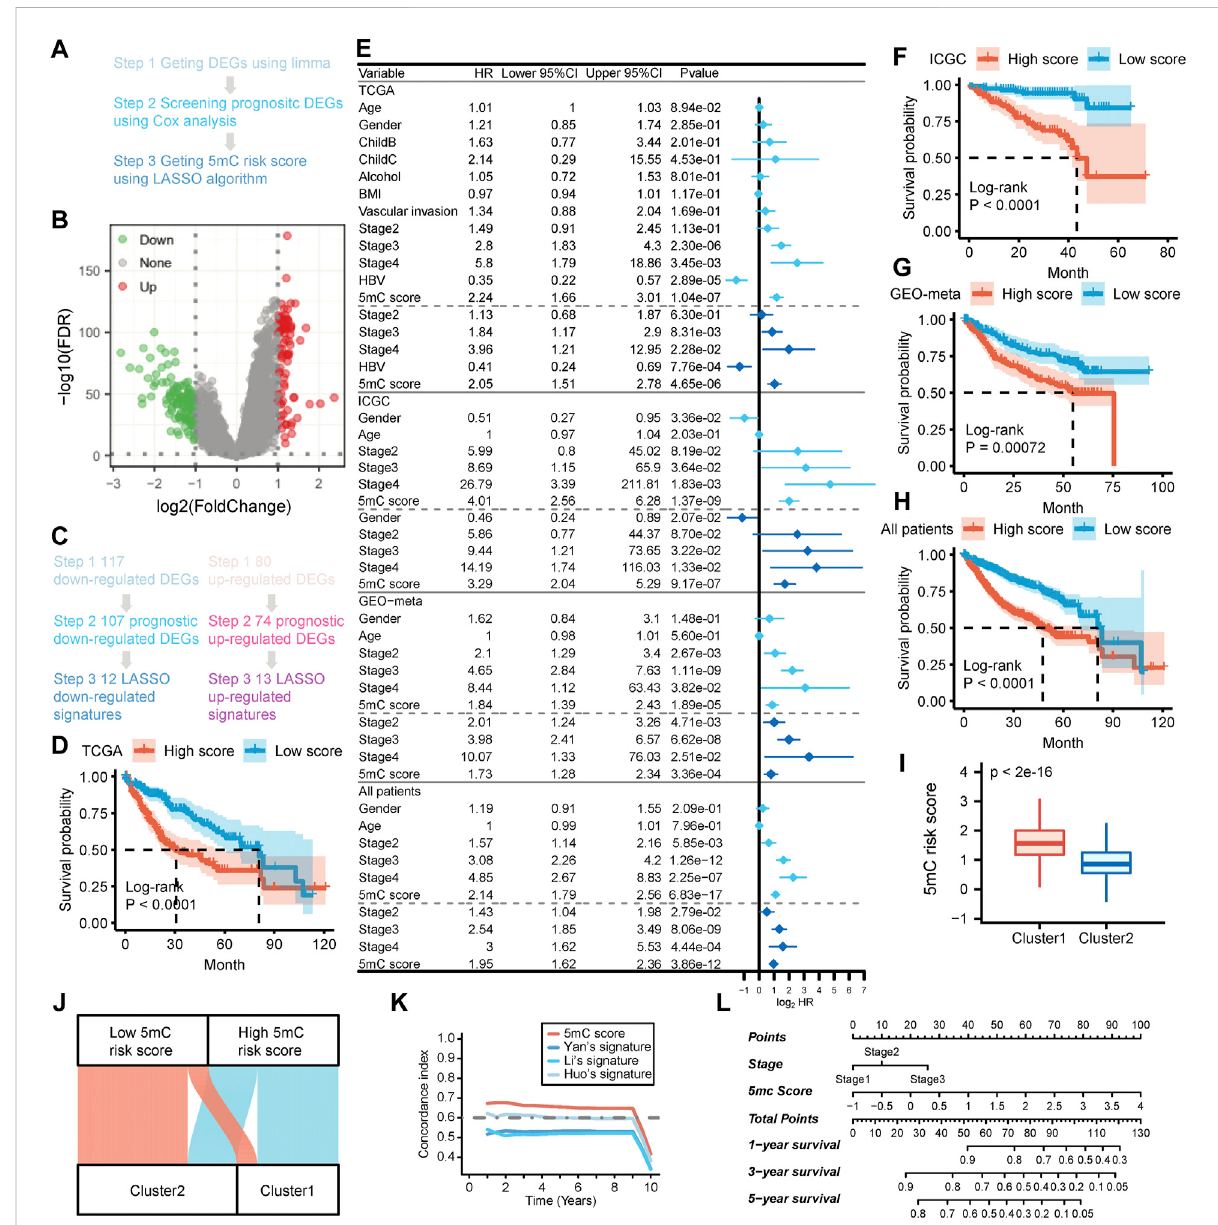
FIGURE 2 Developing the 5 mC gene signature, 5 mC score and exploring the clinical practice in the meta cohort. (A) The fl ow chart of the 5 mC score algorithm. (B) The volcano plot of the differentially-expressed genes (DEGs) between 5 mC subtypes. (C) Screening outcomes of 5 mC